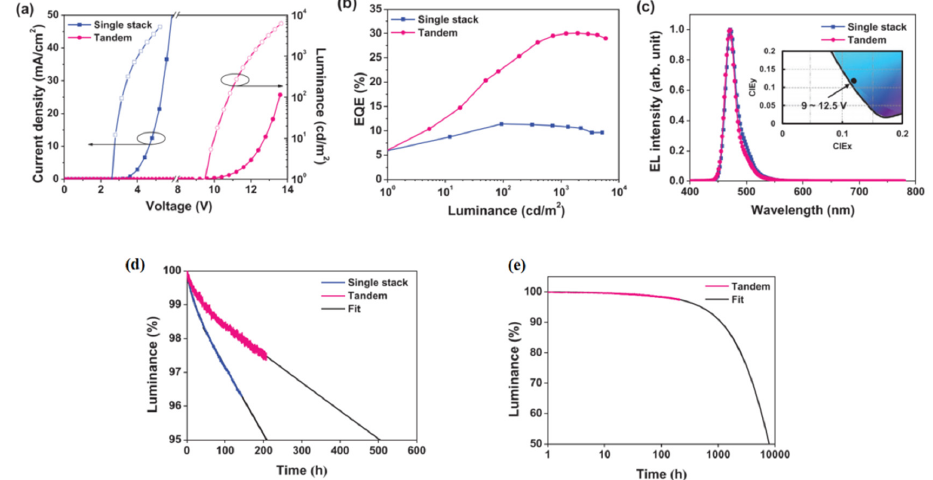
Figure 4. ( a ) J–V–L and ( b ) EQE-L characteristics, ( c ) EL spectra and CIE coordinates (inset), and ( d ) lifetime data of single stack and tandem devices. ( e ) Extrapolated plot of the tandem device. Reproduced with permission from Jinho Park, Ki Ju Kim, Junseop Lim et al., “High Efficiency of over 25% and Long Device Lifetime of over 500 h at 1000 nit in Blue Fluorescent Organic Light-Emitting Diodes”; published by John Wiley and Sons , 2022